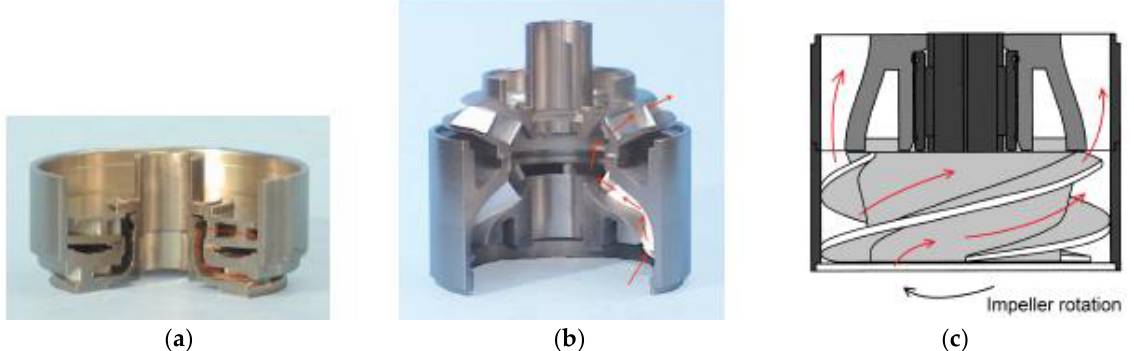
Figure 2. Representation of radial, mixed and axial flow geometries with impeller and stationery diffuser. The red arrows indicate the flow path [23]. ( a ) Radial geometry; ( b ) mixed geometry; ( c ) axial geometry.